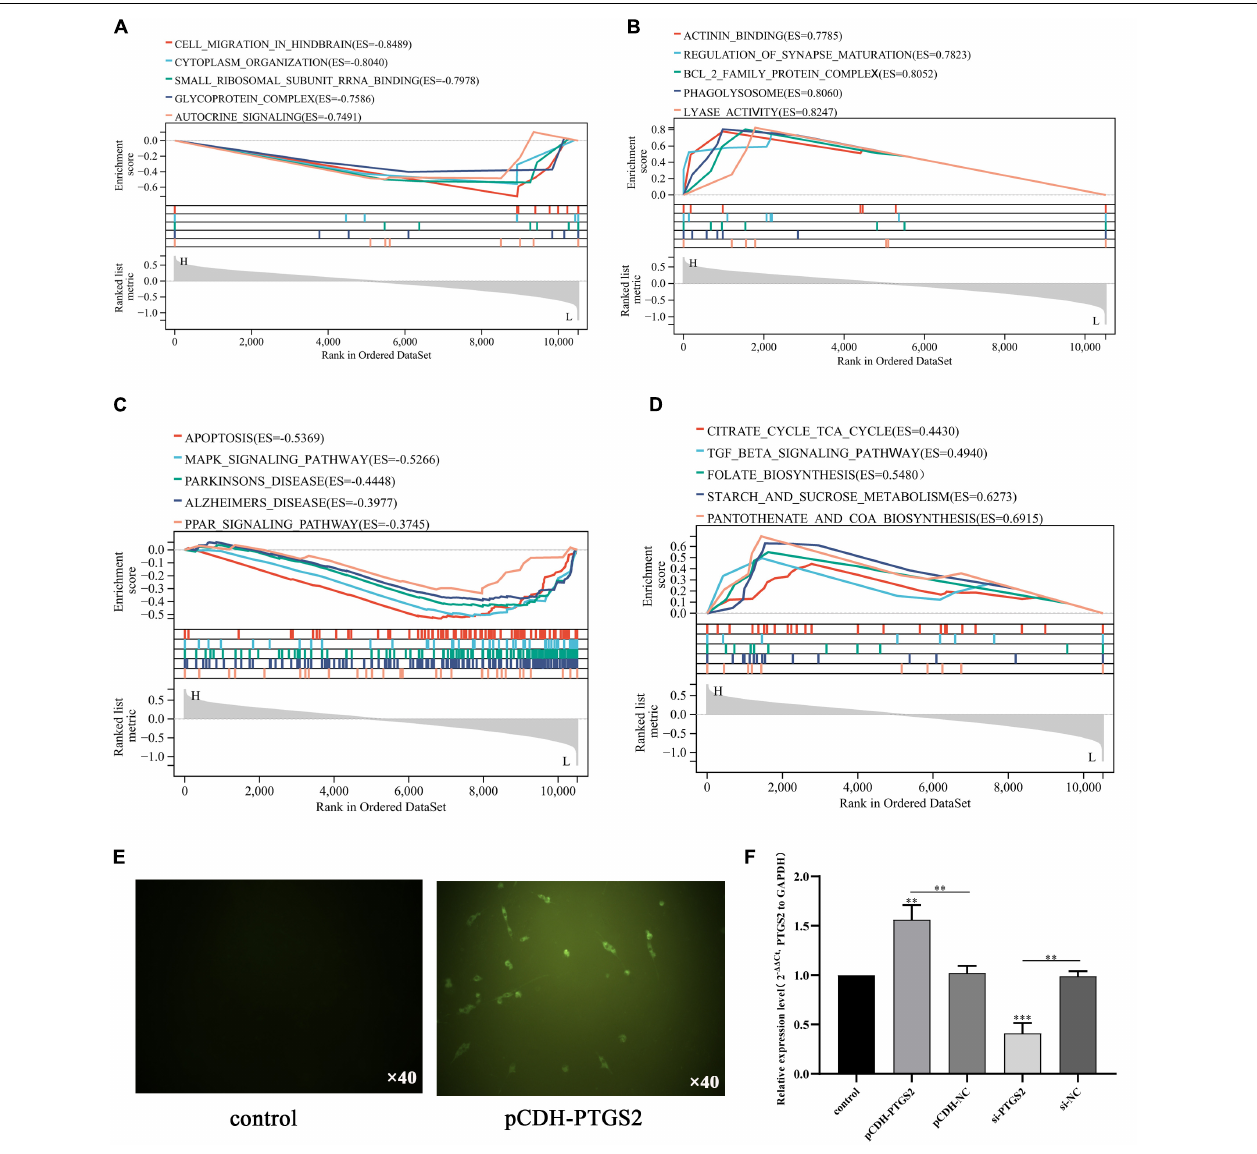
FIGURE 6 | Gene set enrichment analysis revealed five positively correlated GO term with lower expression PTGS2 (A) , five negatively correlated GO term with lower expression PTGS2 (B) , five positively correlated KEGG pathway with lower expression PTGS2 (C) , and five negatively correlated KEGG pathway with lower expression PTGS2 (D) . (E) The transfection efficiency of pCDH-PTGS2 was detected by fluorescence microscope. Scales: 10 × 40. (F) The transfection efficiency of pCDH-PTGS2 and si-PTGS2 was detected by qPCR. The expression level of GAPDH was used as an internal reference for PTGS2. The data are shown as the mean ± standard deviation. The horizontal line indicates the comparison between groups at both ends, and the non-horizontal line indicates the comparison with the control group. ∗∗∗ p < 0.001; ∗∗ p < 0.01.